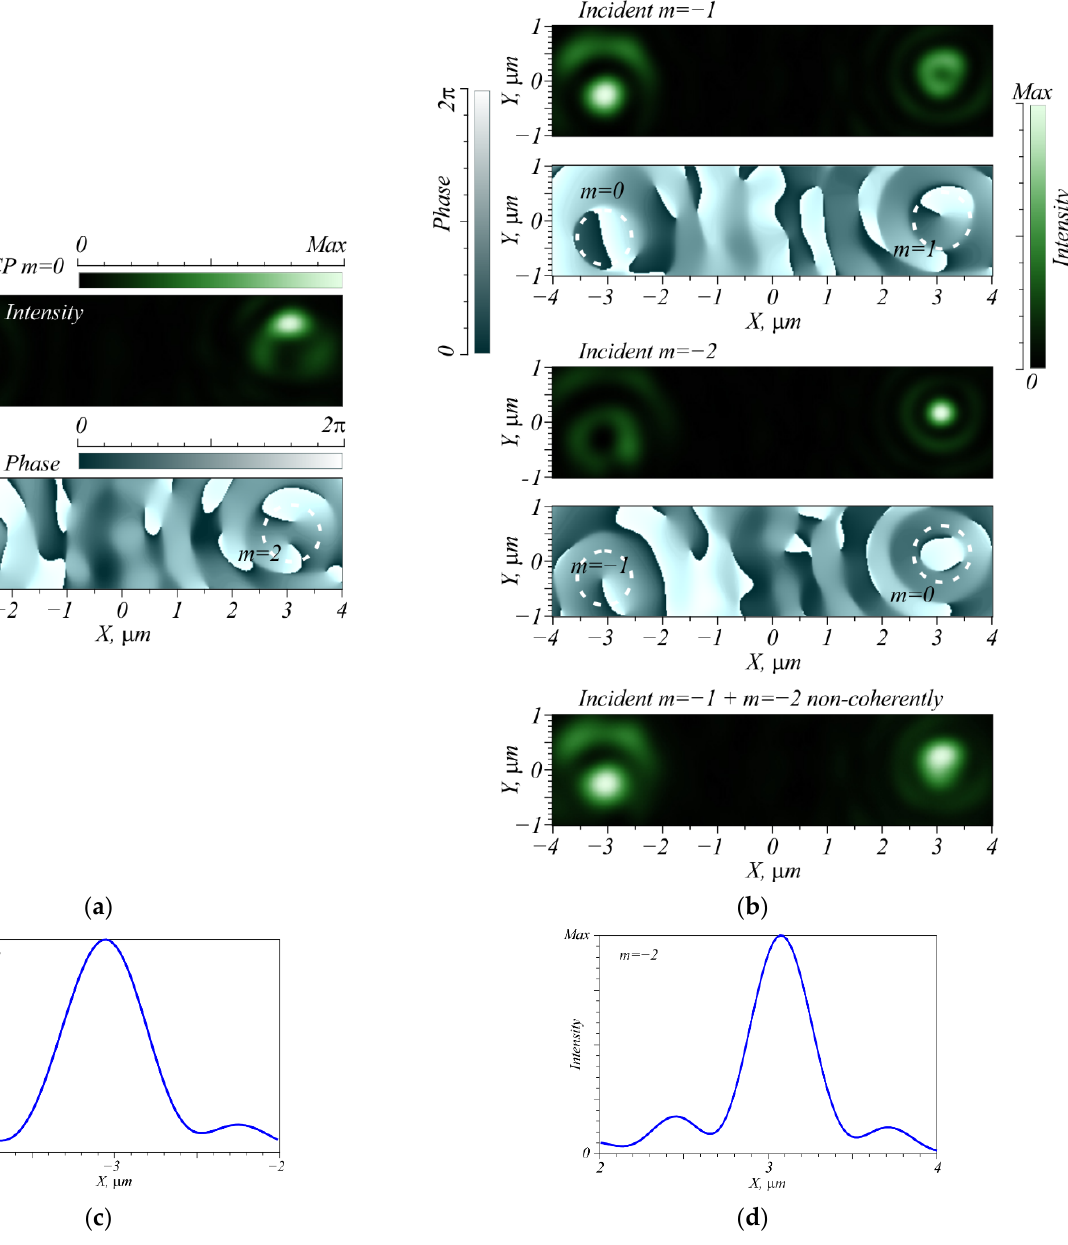
Figure 2. ( a ) Intensity and phase of the output light when the incident light is a non-vortex LHCP plane wave, ( b ) intensity and phase at the metalens output from an incident beam with TC m = − 1 ( top ), m = − 2 ( middle ), both TCs at once ( bottom ), and ( c , d ) their profiles along the X axis. The wavelength is λ = 0.633 μ m. Dashed rings imposed on the phase patterns show the location of the vortices.